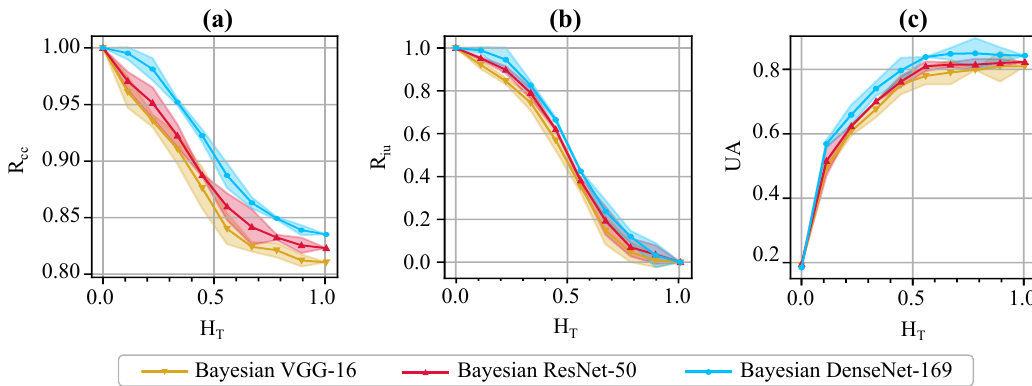
Figure 7. Quantitative evaluation of the uncertainty estimates via the proposed metrics. Illustrates the values of R cc ( a ), R iu ( b ), and UA ( c ) for varying thresholds of uncertainty ( H T ∈ [ 0,1 ] ). The shaded area around each curve shows one standard deviation for the 5-fold